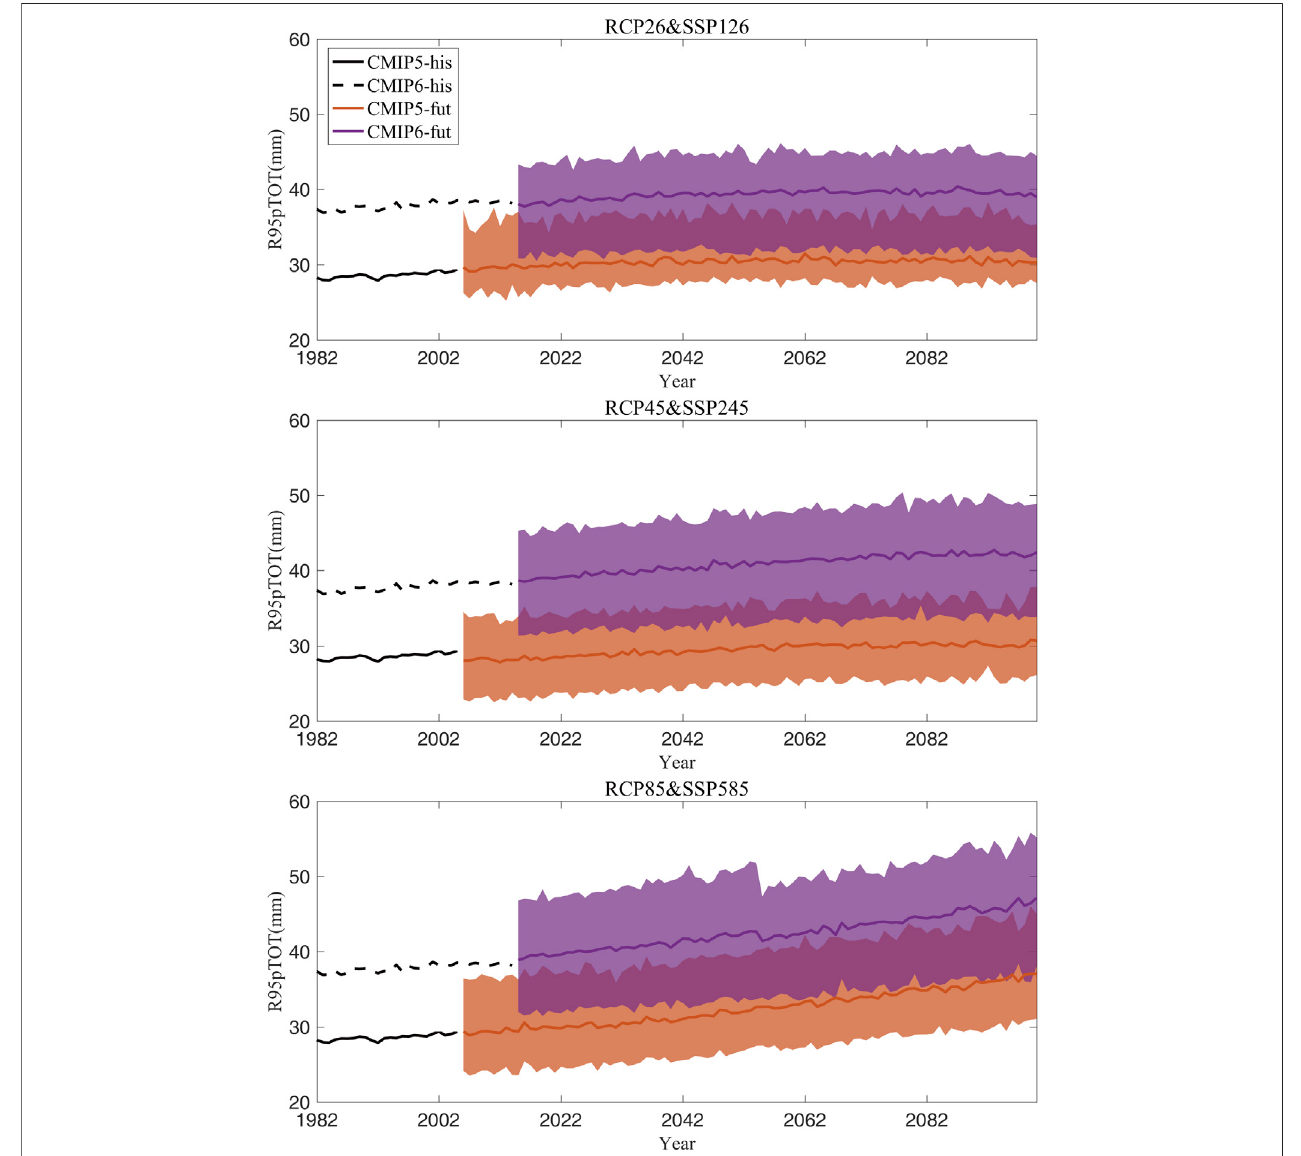
FIGURE14| Globalland-averagemulti-modelmeanR95pTOTduring1982 – 2100inCMIP5andCMIP6.Theshadedregionshowstheuncertaintyrange(between the 25 quantiles and the 75 quantiles).